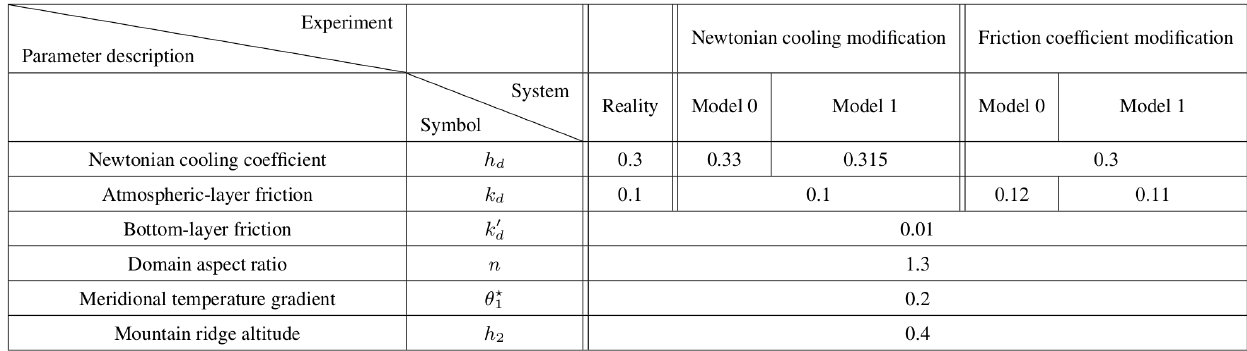
Figure 1. Dynamics of the reference system and model 0 of the postprocessing experiment with a modification of the friction coefficient (see Table 1) for (a) time evolution of the variable θ 1 and (b) time evolution of the variable ψ 2 . Table 1. The main parameters used and modified in the experiments. Model 0 and model 1 are respectively the forecast model of reality before and after the model